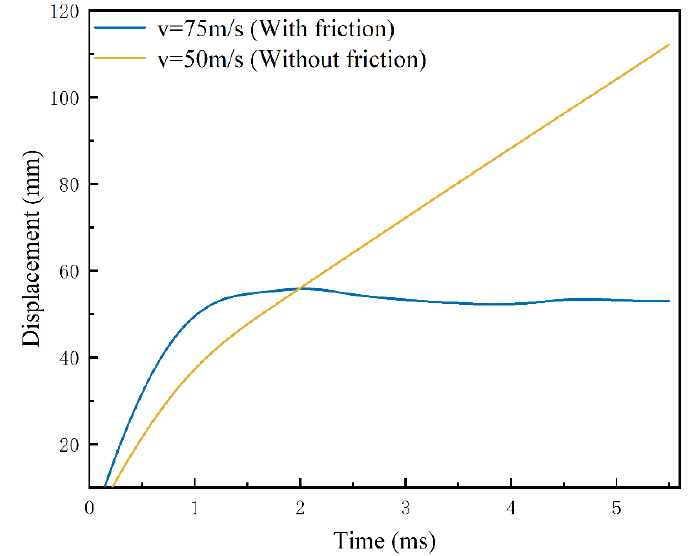
Figure 11. Harpoon displacement curve.